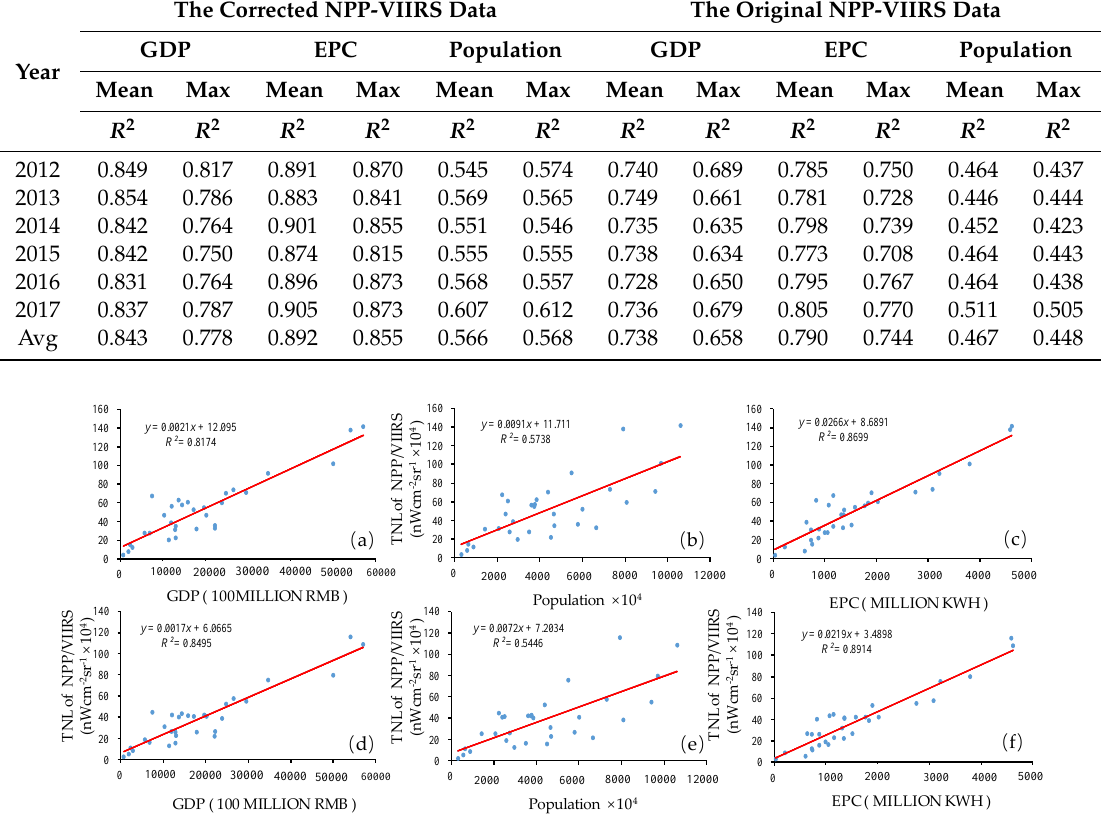
Figure 4. The scatter diagram of the linear regression analysis at the provincial scale. TNL: total nighttime light. Linear regression of (a) the corrected NPP-VIIRS maximum data and GDP; (b) the corrected NPP-VIIRS maximum data and population; (c) the corrected NPP-VIIRS maximum data and EPC; (d) the corrected NPP-VIIRS mean data and GDP; (e) the corrected NPP-VIIRS mean data and population; (f) the corrected NPP-VIIRS mean data and EPC.